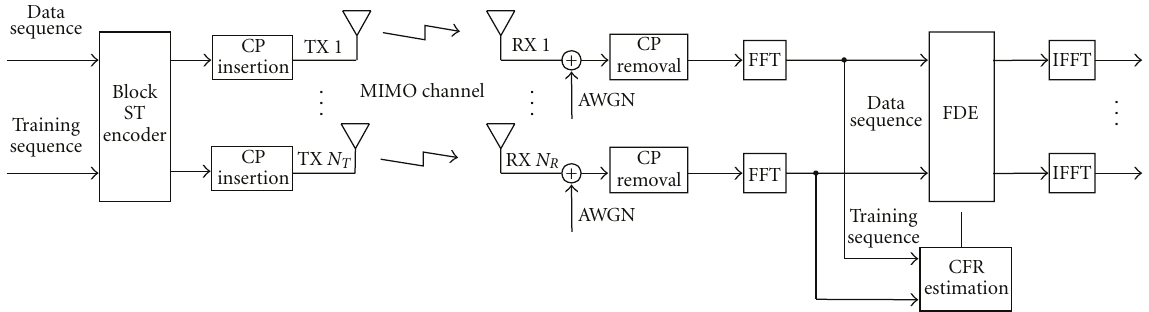
Figure 1: Block diagram of the CFR estimation for MIMO system with STC and